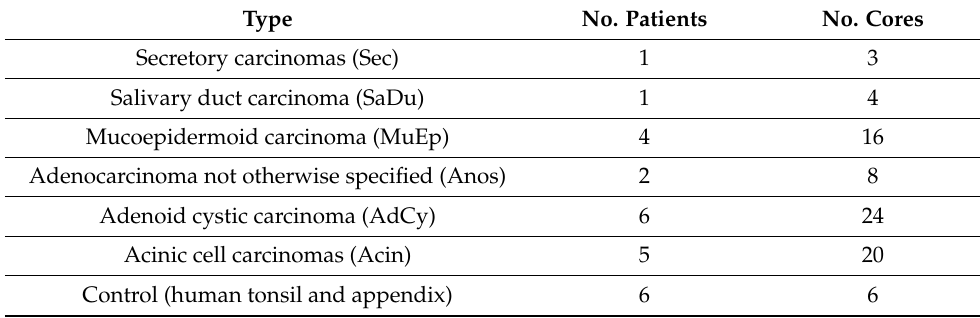
Table 1. Patient and sample